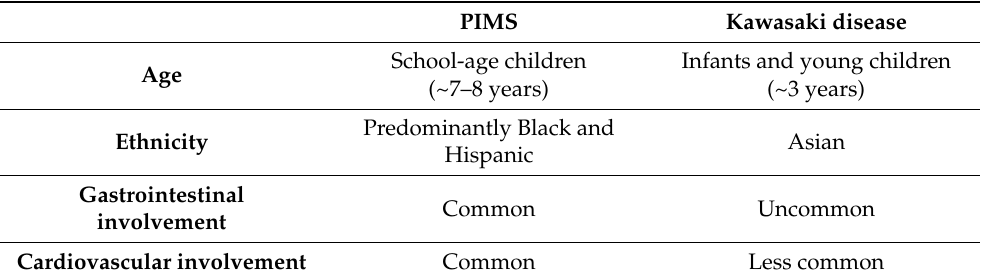
Table 1. A summary of the main differences between paediatric inflammatory multisystem syndrome temporally associated with COVID-19 (PIMS) and Kawasaki disease.